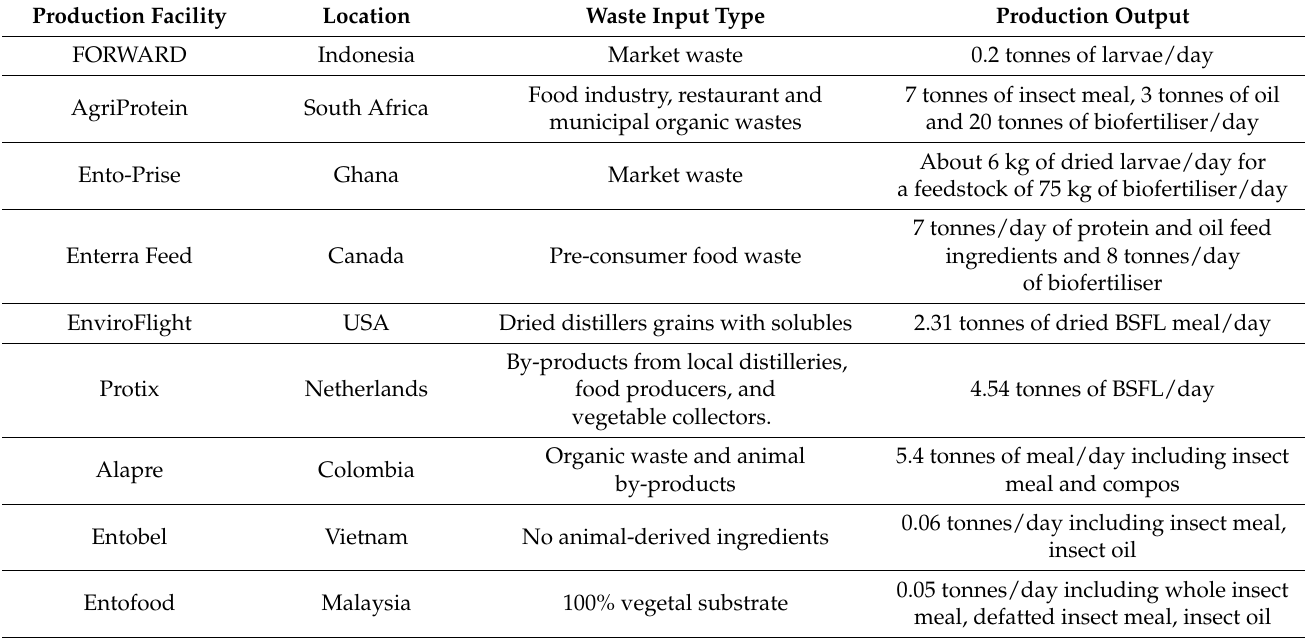
Table 1. BSFL production tested for the industrial production of animal feeds. The production facilities, location, feedstock, and production output are identified